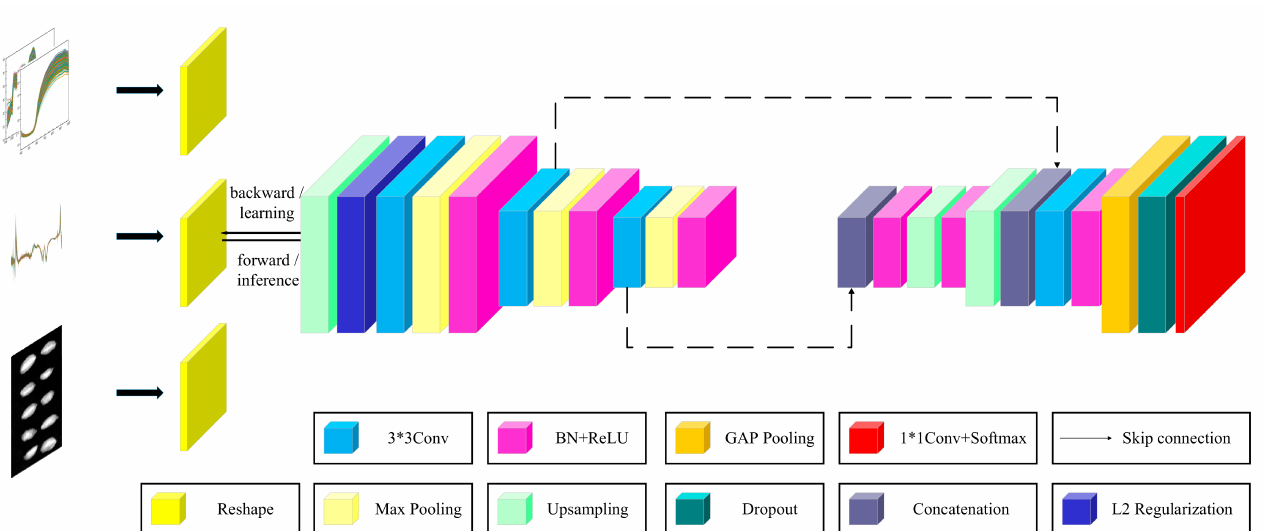
1 ∗ 1 convolutional layer and softmax to output the result. More details of the other layers are described in Section